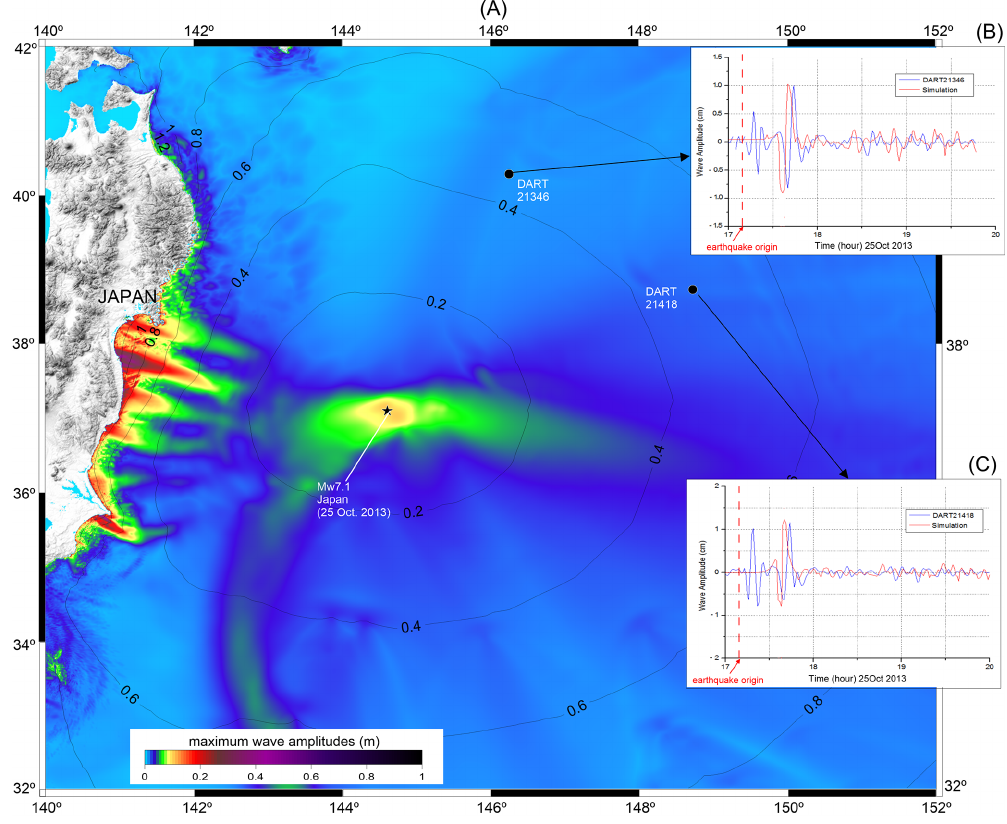
Figure 7. Tsunami numerical simulation of the 25 October 2013 Japan tsunami event: (a) maximum wave amplitudes distribution in the west Pacific Ocean and tsunami travel times (dark lines separated each 0.2h); (b) comparison between the simulated waveform and recorded signal for the station DART ® -21346; (c) comparison between the simulated waveform and recorded signal for the station DART ®